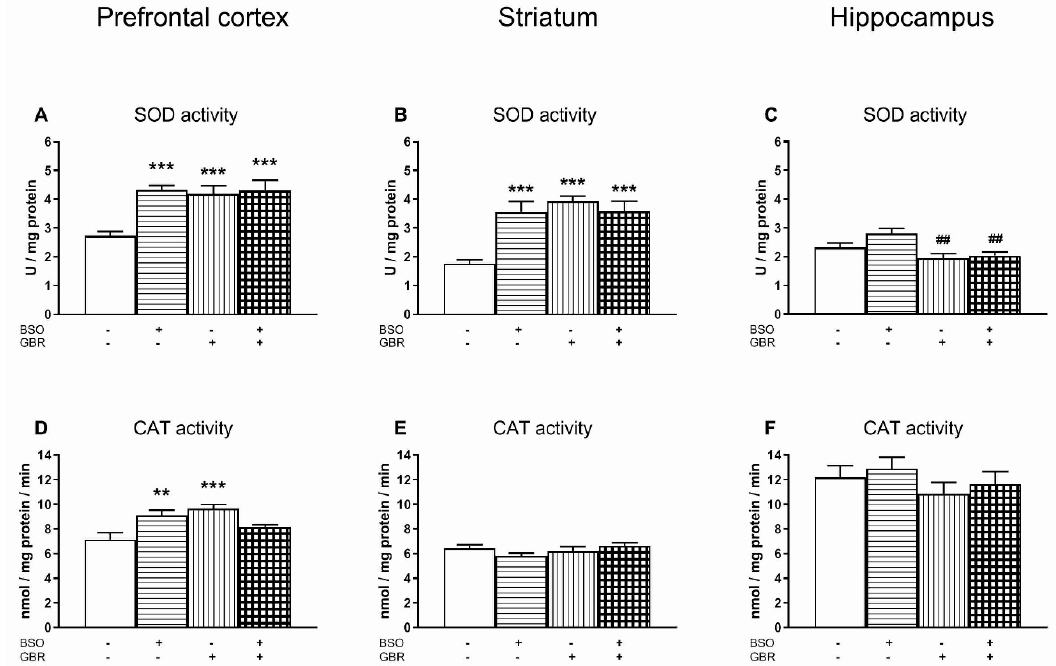
Figure 2. The effect of chronic administration of BSO and/or GBR 12909 on the enzymatic activities of superoxide dismutase (SOD; 2A–2C ) and catalase (CAT; 2D–2F ) in the prefrontal cortex, striatum and hippocampus of 16-day-old rats. Activity of SOD is expressed in U/mg of protein (the amount of enzyme needed to produce 50% dismutation of O 2 • − radical), the activity of CAT is expressed in nmol/mg of protein/min (the amount of enzyme that causes the formation of 1 nmol of formaldehyde during 1 min per mg of protein). The bars representing SOD or CAT activity in particular groups show the mean ± SEM, n = 8. Symbols indicate significance of differences according to the Bonferroni post-hoc test, ** p < 0.01, *** p < 0.001 vs. control- and ## p < 0.01 vs. BSO-treated groups.